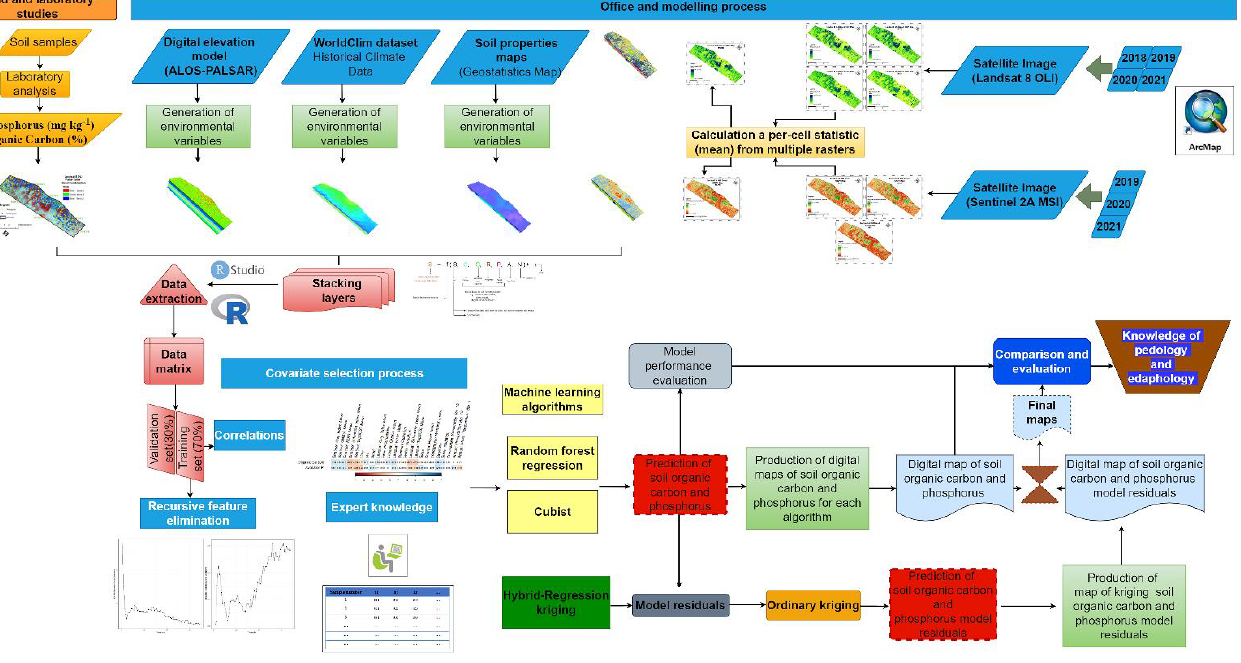
Figure 2. Flowchart of the methodology of the study.